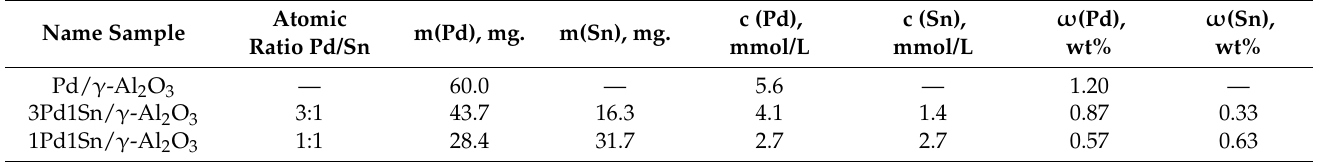
Table 3. The theoretical calculated content of metals in synthesized samples.